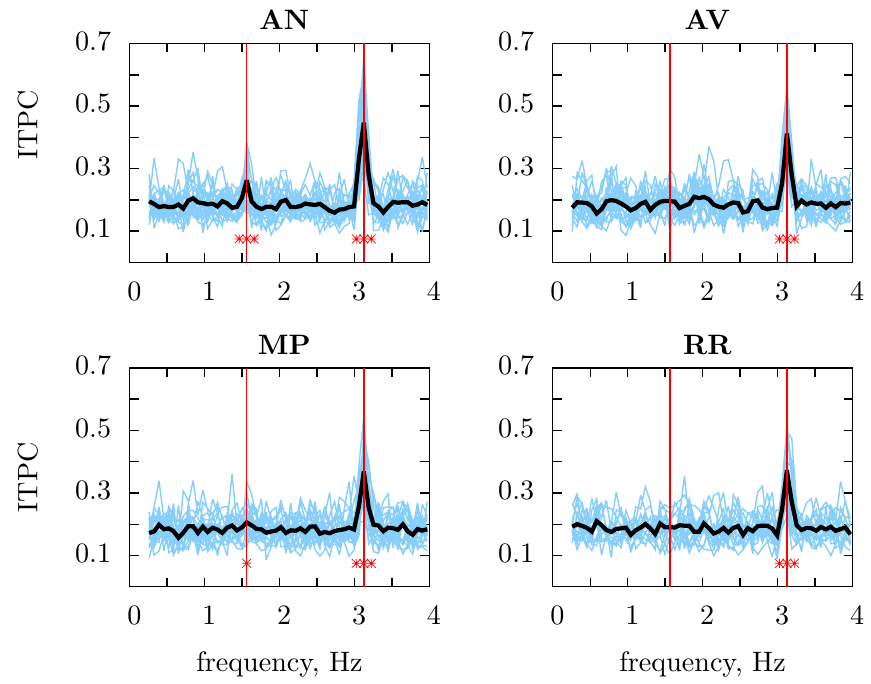
Figure 3. EEG responses recorded in human participants for each of the four conditions. Statistically significant peaks in ITPC values were observed at the rate of syllable presentation (3.125 Hz) in each of the four conditions (AN, AV, MP, RR). A statistically significant peak in ITPC is observed at the rate of phrase presentation (1.5625 Hz) in the AN and MP conditions. Red stars represent statistical significance ⋆ : p < 0.05 , ⋆⋆ : p < 0.01 and ⋆ ⋆ ⋆ : p < 0.005 . Vertical red lines represent the frequency at which syllables and two-word sequences are